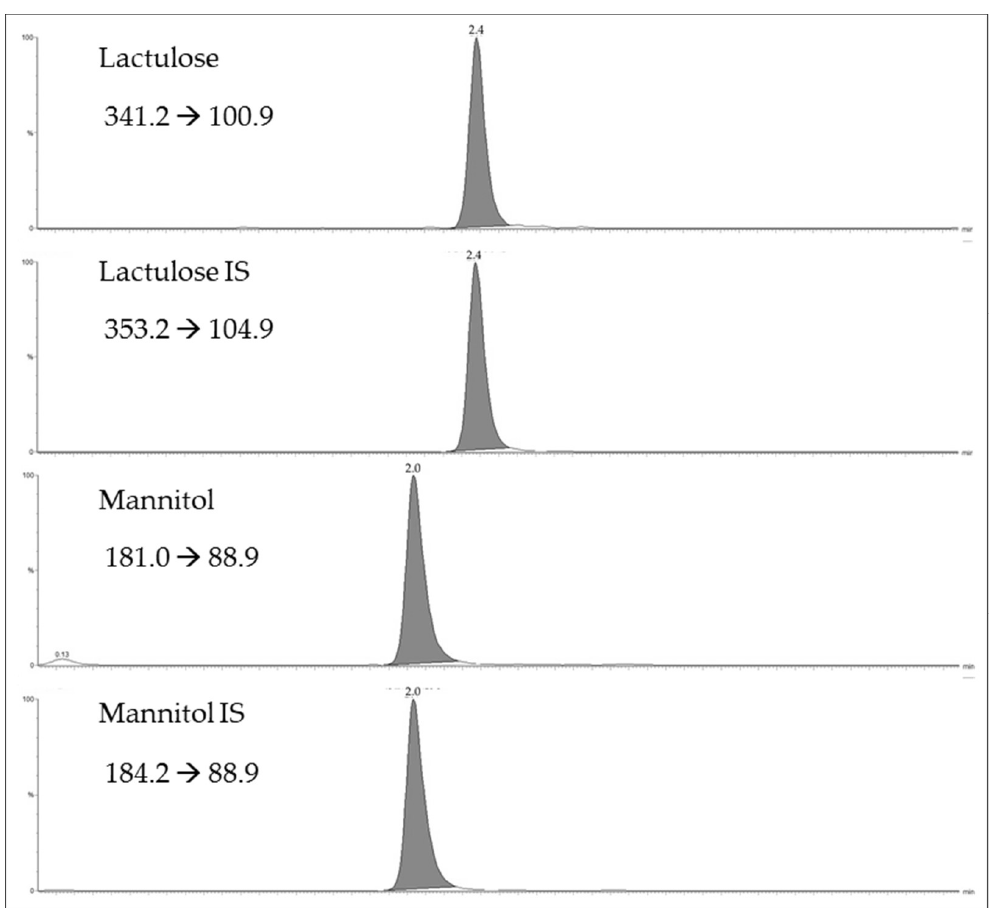
Figure 1. Selected reaction monitoring (SRM) chromatograms for lactulose, mannitol and their internal standards lactulose 13 C 12 and D -mannitol-1 13 C,1-1-d 2.